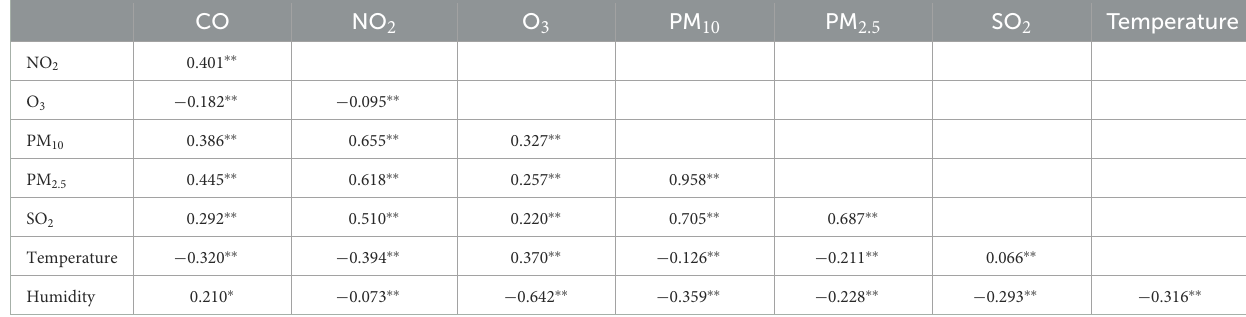
TABLE 3 Spearman correlation analysis between air pollutants and meteorological factors in Ganzhou